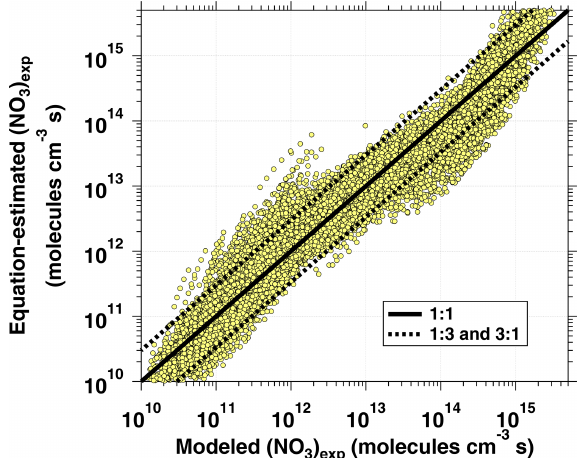
Figure 10. NO 3exp calculated from the estimation equation (Eq. 6 and Table 1) as a function of NO 3exp calculated from the full OFR- iN 2 O 5 KinSim mechanism (Table S2). Solid and dashed lines cor- respond to the 1 : 1 and the 1 : 3, and 3 : 1 lines,